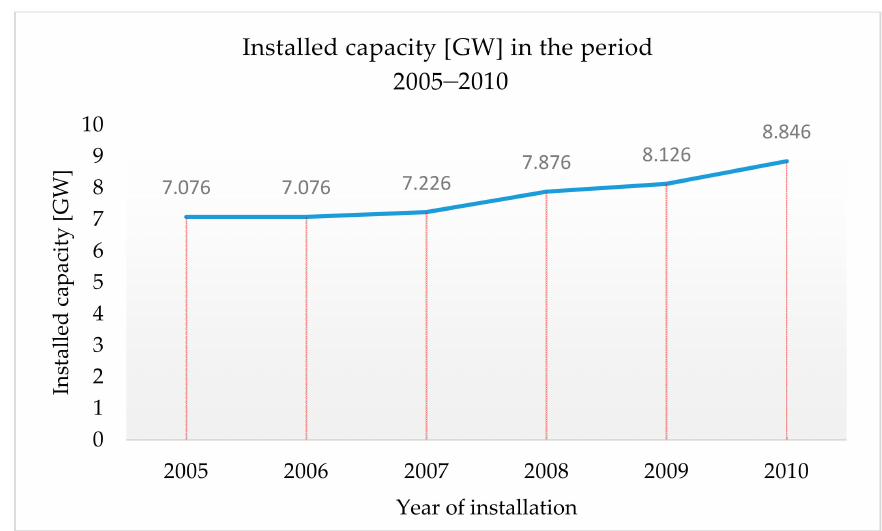
Figure 2. Installed capacity [MW] in the period 2005–2010.